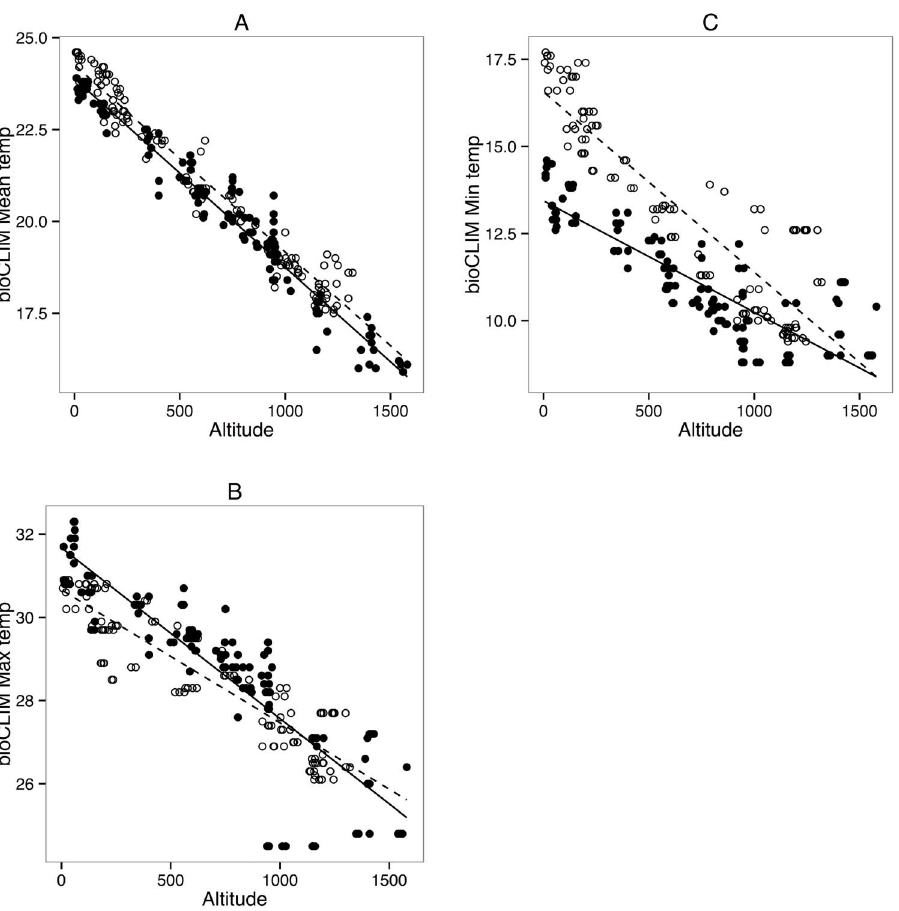
Figure 2. Relationships between elevation and temperature parameters for the study region. A: Mean Annual Temperature (MAT), B: Maximum Temperature of the Warmest Period (T max ) and C: Minimum Temperature of the Coolest Period (T min ). Data were interpolated from bioCLIM, and sites in the southern AWT (filled circles) and northern AWT (unfilled circles) are indicated. The solid lines are simple linear models of the effect of elevation on temperature for each parameter, with the trend for southern sites shown by a solid line, that for northern sites with a dashed line. Corresponding data for accuCLIM climate surfaces (see text) are shown in figure S1.